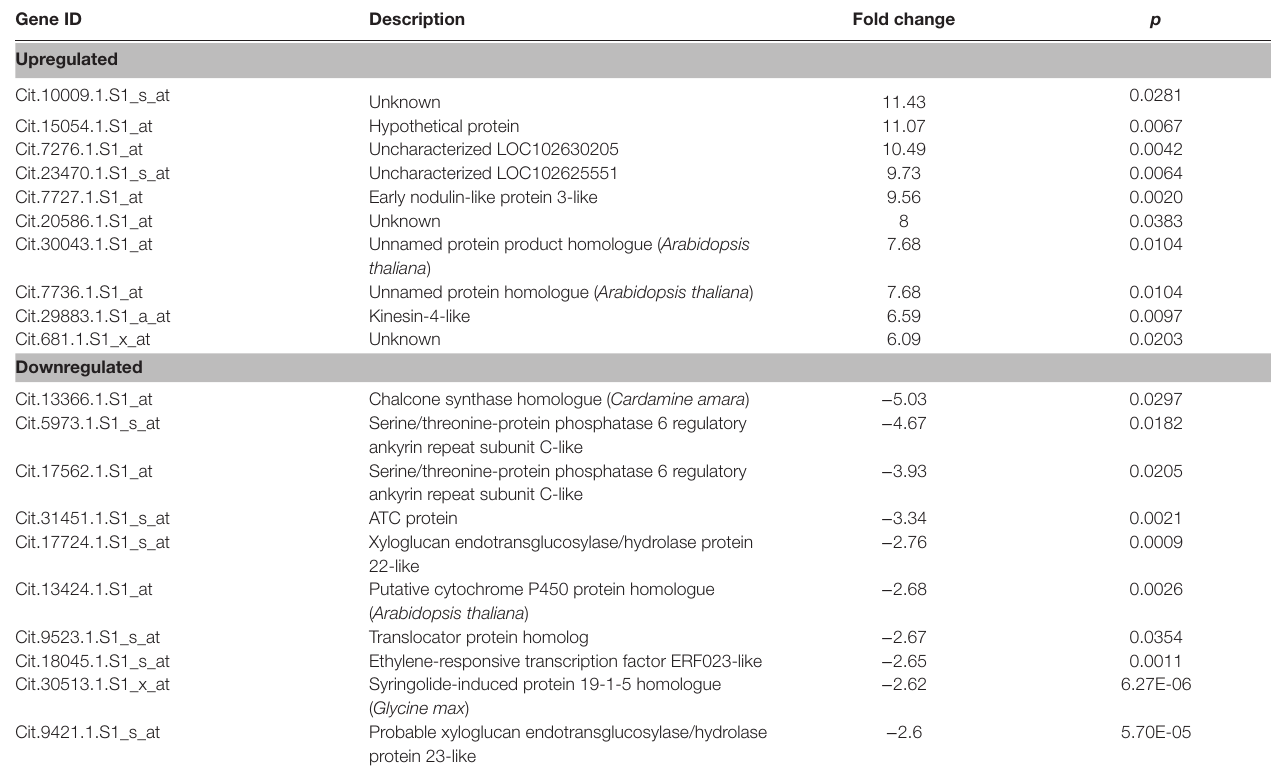
TABLE 3 | A sample of the differentially expressed genes in the control vs. infected